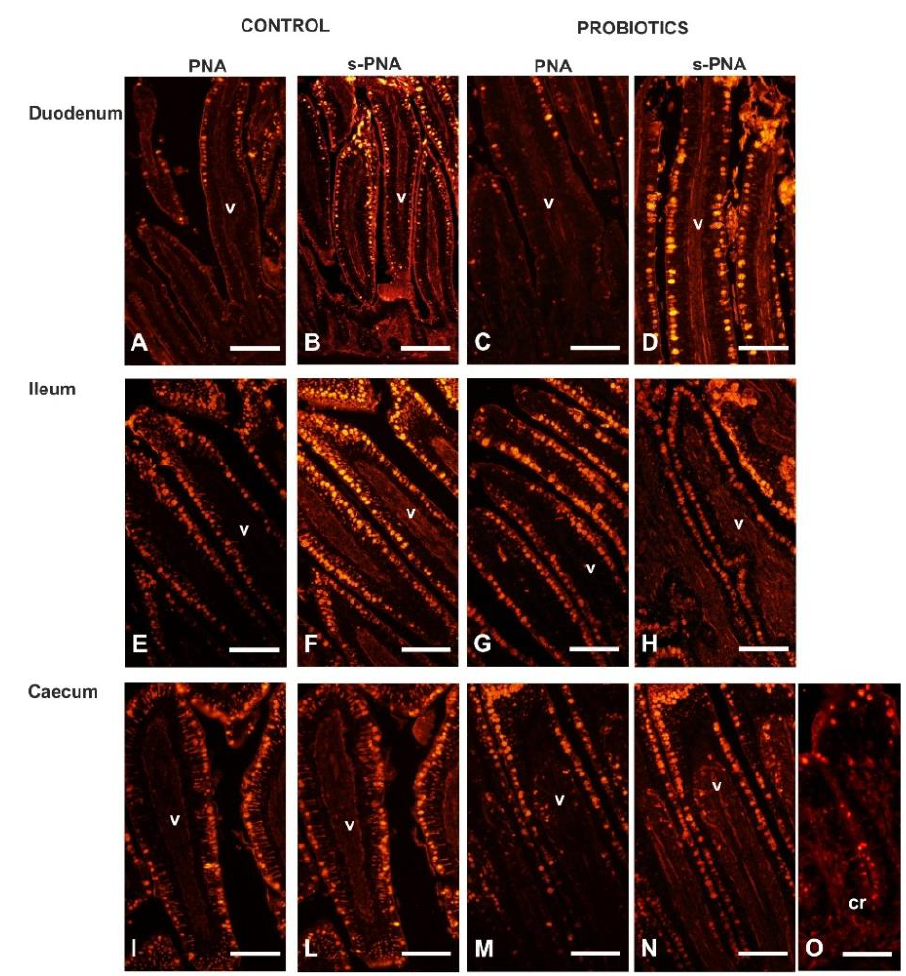
Figure 5. Reactivity pattern of Peanut agglutonin (PNA) ( A , C , E , G , I , M , O ) and sialidase (s)PNA ( B , D , F , H , L , N ) with intestinal mucosa of Cand P guinea fowls. cr, crypt; v, villus. Scale bars: A–O, 100 µm.